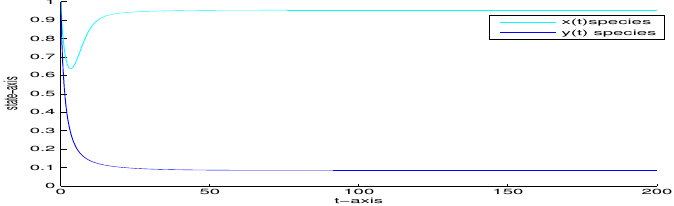
Figure 3. Global stability of E ∗ ( x ∗ , y ∗ ) of Model